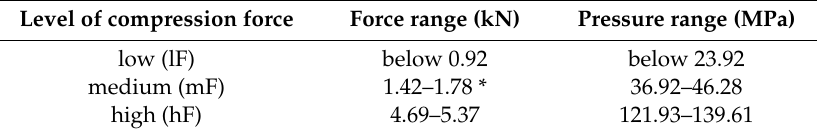
Table 1. Compression force ranges used during